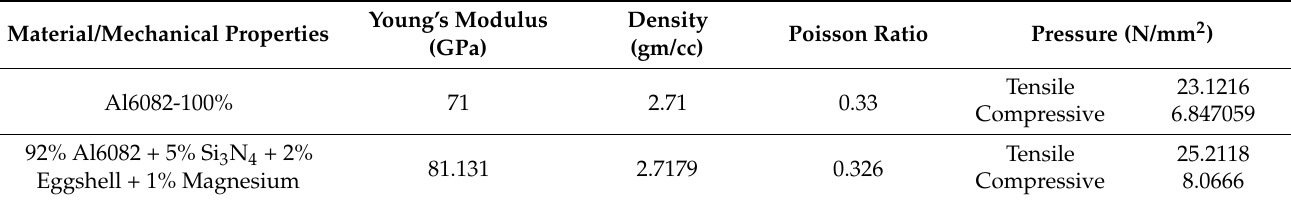
Table 16. Simulation outcomes of nodal and elemental stress on Al6082 and Al + ES + Mg composite.